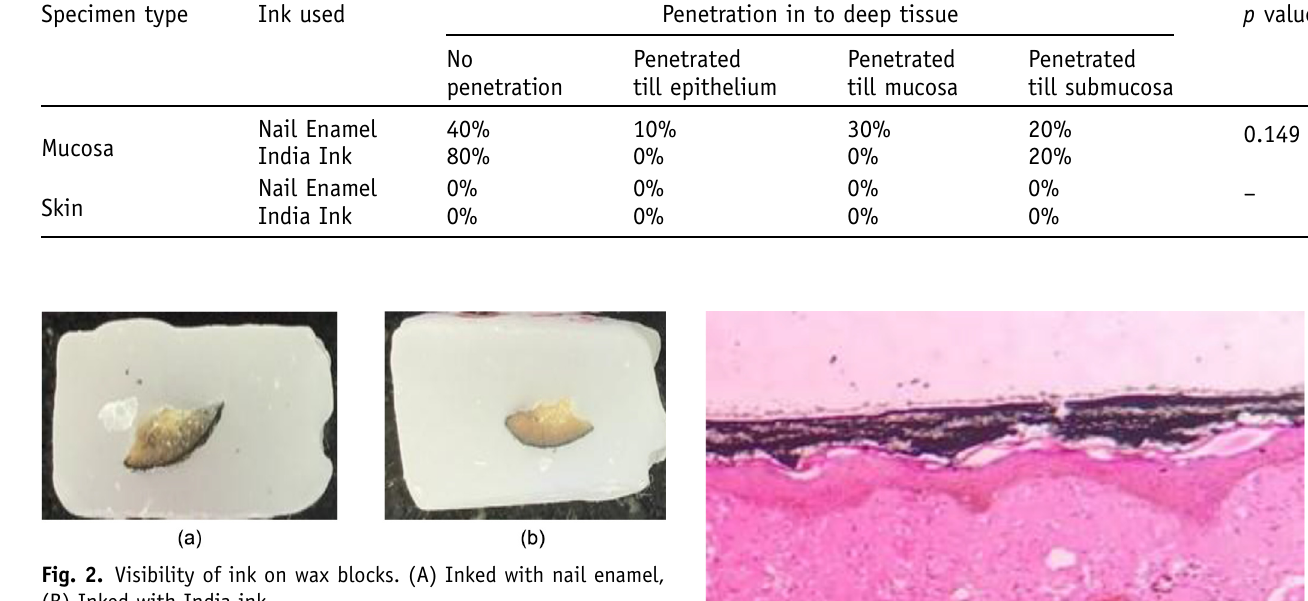
Table IV. Ink used vs penetration in to deep tissue. Specimen type